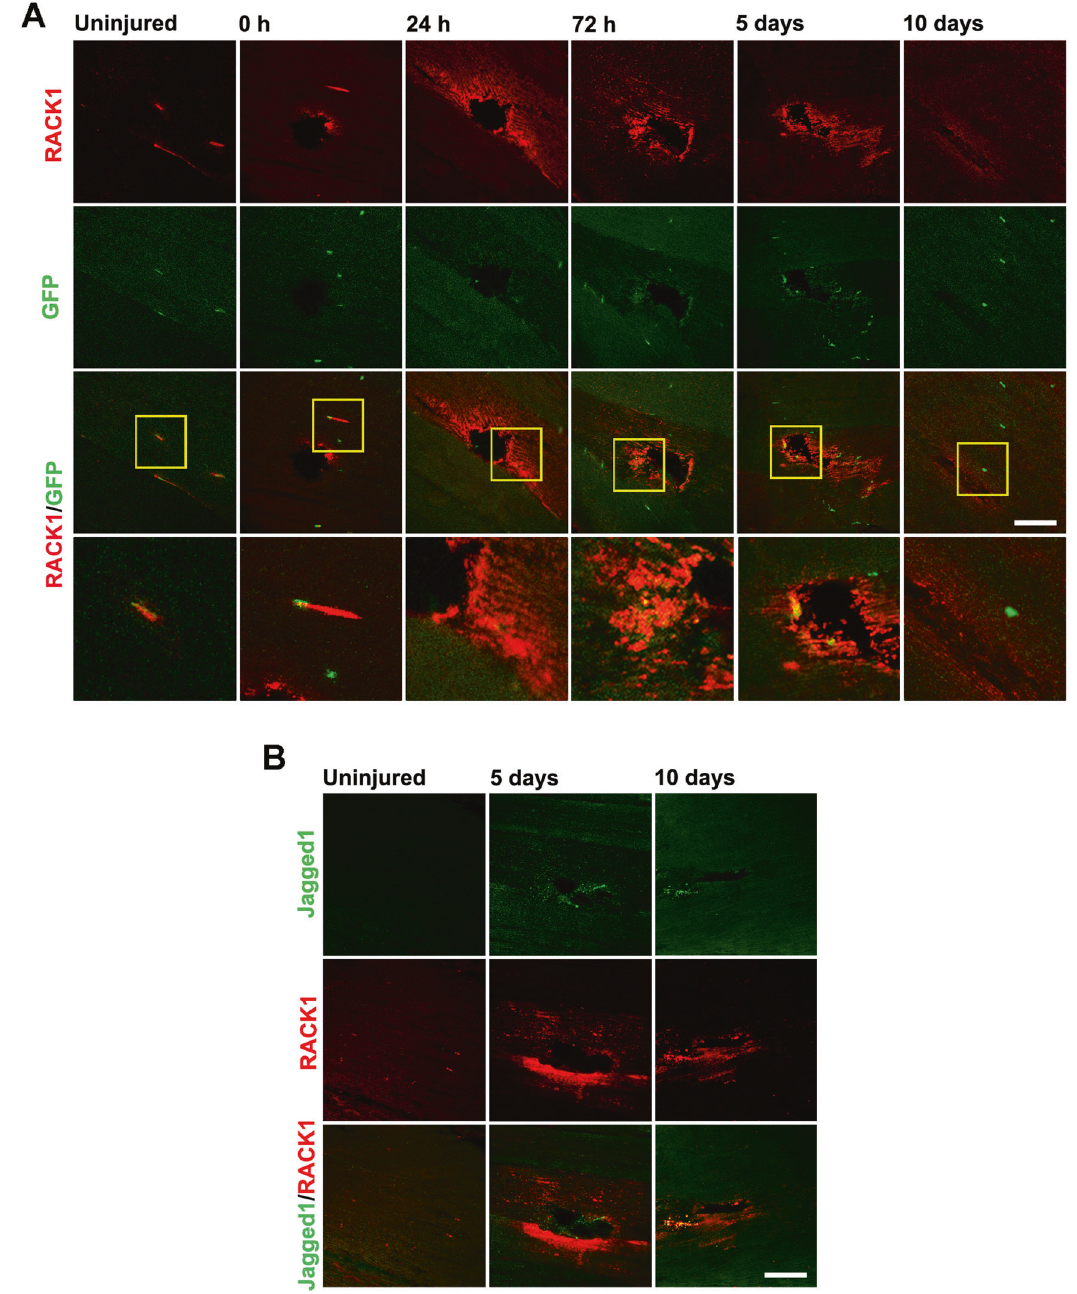
Fig. 5 RACK1 expression in response to D. melanogaster muscle acute injury. A Confocal fl uorescence imaging of RACK1 (red) and GFP (green) in DLM longitudinal sections of Zfh1>GFP fl ies before (uninjured) and after physical damage at increasing times. Inserts represent enlarged image details showed in the low panels. Images are representative of 30 ≤ n ≤ 40 fl ies. B Confocal fl uorescence imaging of Jagged1 (green) and RACK1 (red) in DLM longitudinal sections before (uninjured) and after physical damage at increasing times. Scale bars: 20 µm. Images are representative of 15 ≤ n ≤ 20 fl